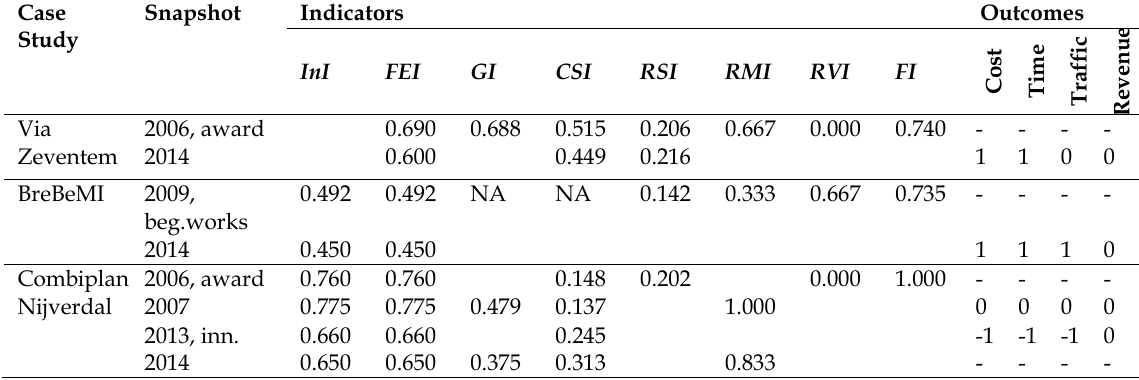
Table 3. Snapshots for road projects in countries with a moderate impact of the